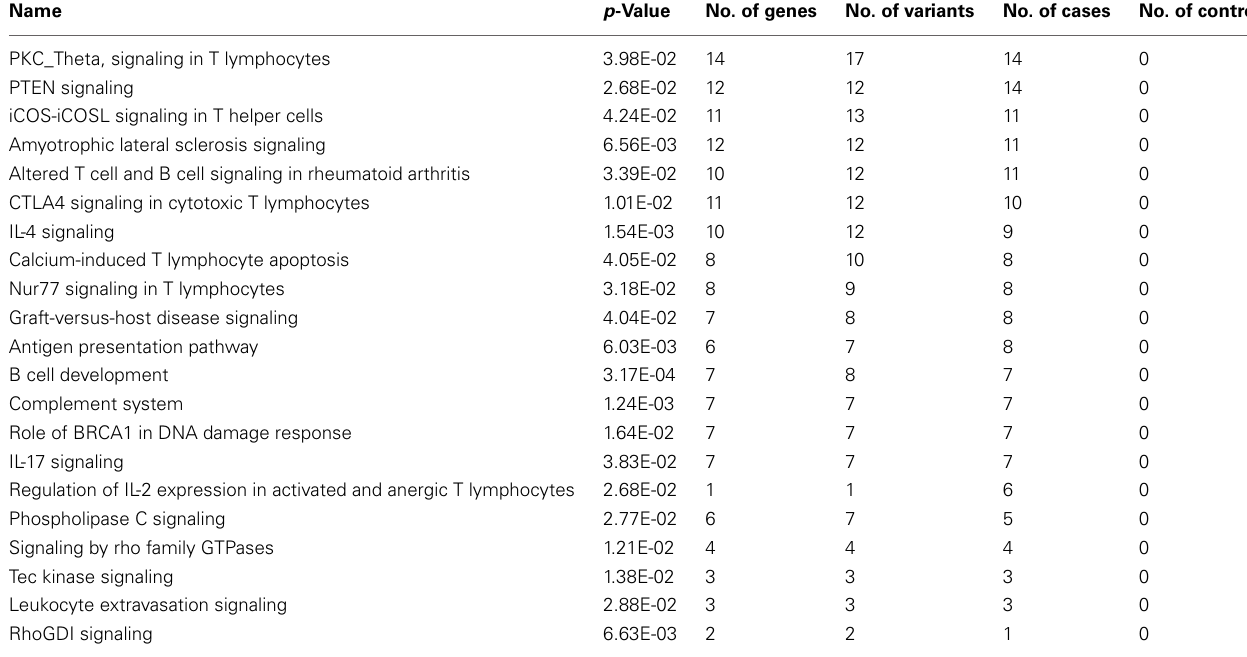
Table 3 | Pathway enrichment for variants present only in relapse cases.